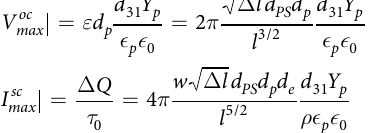
multilayer cladding having ~10 alternating piezoelectric-conductive layers (Fig. 1b,c). After assembly, the struc- ture was then vacuum consolidated into a solid preform at 110 °C. Subsequently, the resulting fiber preform was thermal-mechanically drawn into meters of piezoelectric microsturectured fibers using a fiber drawing tower. Here the BTO-PVDF mats were fabricated in-house via electrospinning. We differed the BTO concentrations